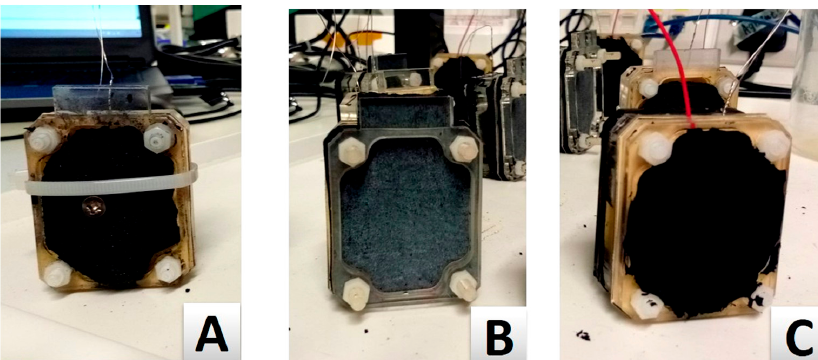
Figure 6. Photographs of the cathode electrodes used in this study. ( A ) AC_BLOCK: Activated carbon block as the commercial option, pierced through with a SS screw as the current collector; ( B ) PTFE_AC: Activated carbon on carbon veil, this PTFE-based electrode was used as the control; ( C ) PTFE_FREE_AC: PTFE-free alginate based electrode as the extrudable